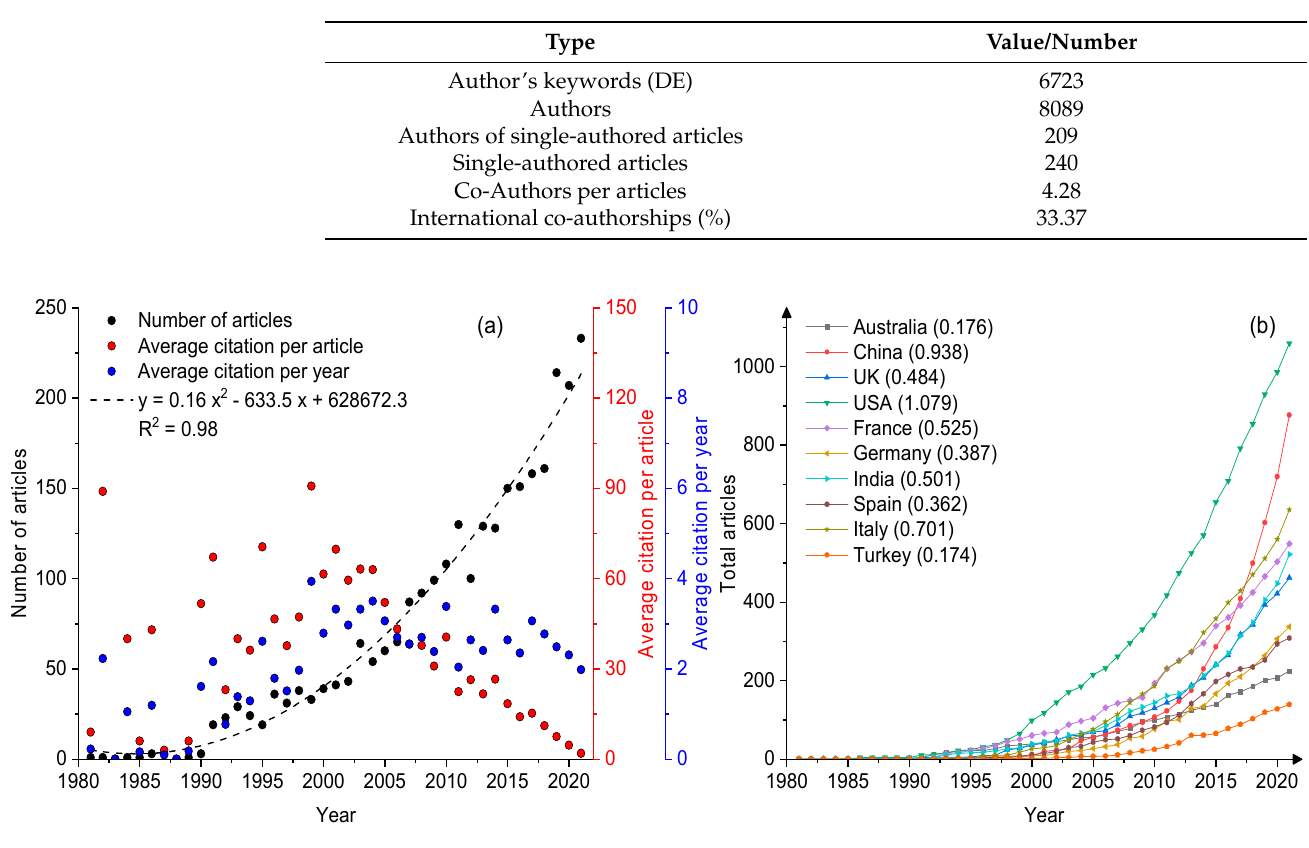
Figure 1. ( a ) Temporal changes in transient tectonic geomorphology research from 1981 to 2021, ( b ) the total article difference between the countries for tectonic geomorphology research from 1981 to 2021.